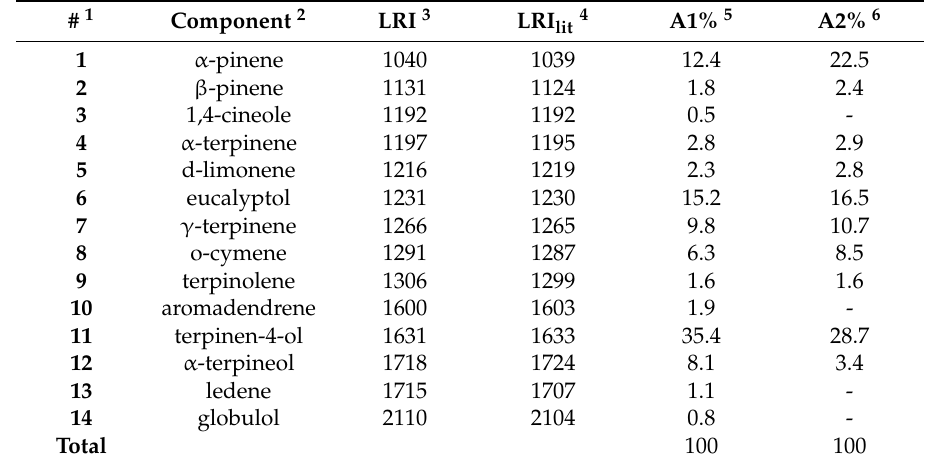
Table 1. Chemical composition (%) of